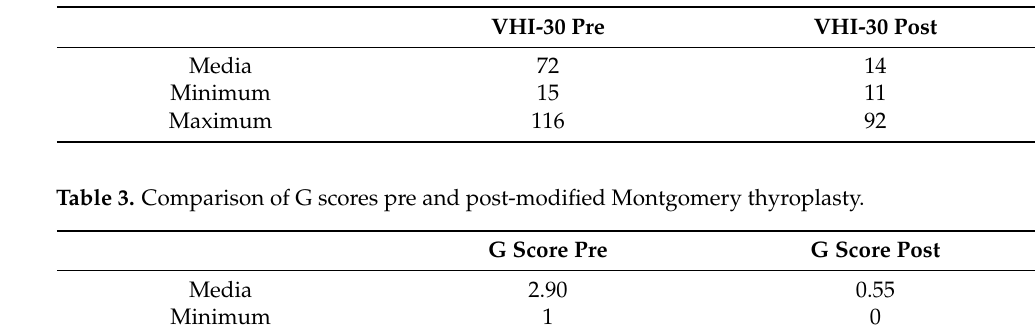
Table 2. Comparison of VHI-30 scores pre and post-modified Montgomery thyroplasty.